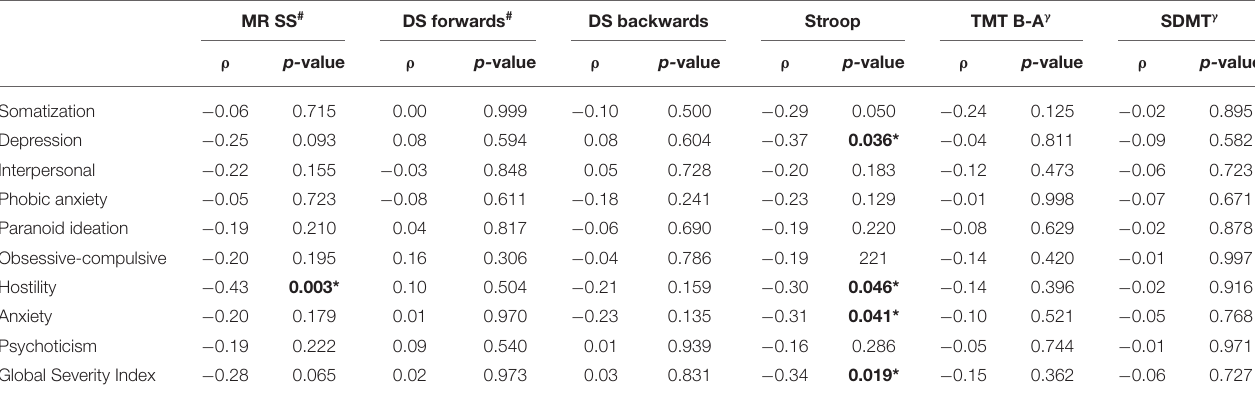
TABLE 2 | Spearman’s rank correlation ( ρ ) between cognitive-executive measures and SCL-90-R psychiatric symptoms, adjusted for age and/or year of education (whenever appropriate).